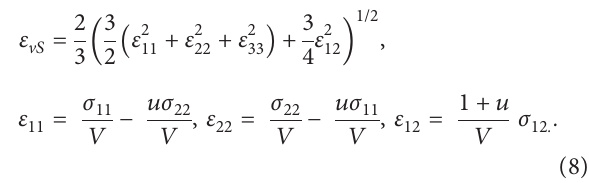
Figure 3: Experimental and RoHM tensile modulus of banana/sisal fiber composites